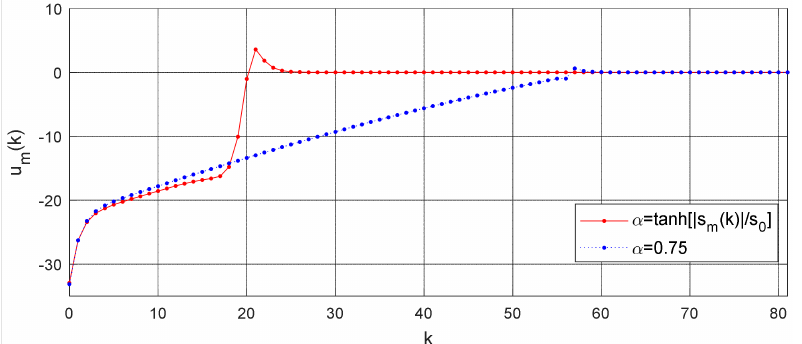
Figure 2. Comparison of the model’s sliding-variable evolution for α ( k ) = tanh[| s m ( k )|/ s 0 ] and α = 0.75.